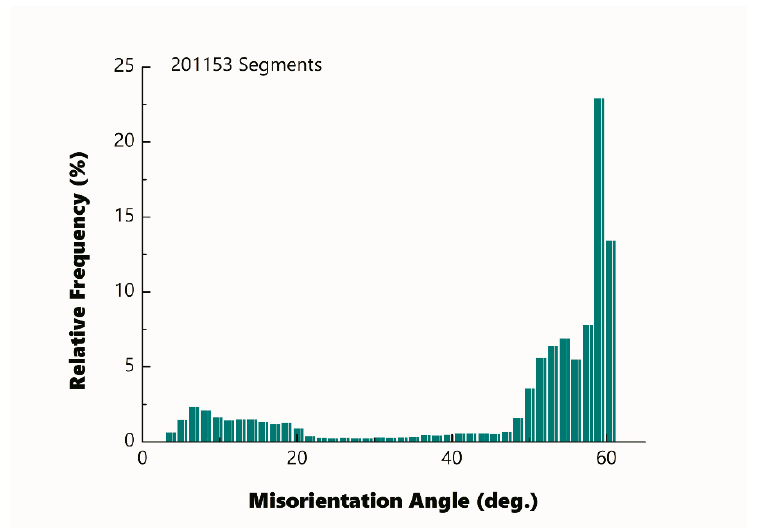
Figure 3. Experimental grain boundary misorientation distribution of the hierarchical microstructure investigated. The grains with misorientation ≤ 2° were treated as one unit.